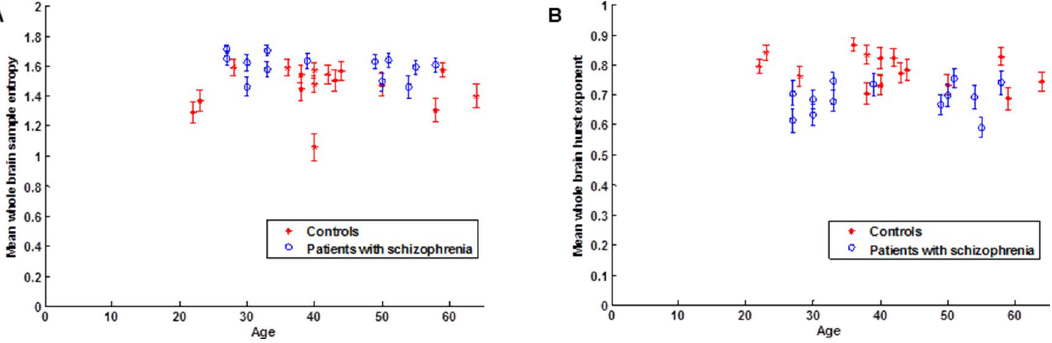
Figure 2. Plots of mean whole brain complexity of the individual participants with increasing age. (A) Mean whole brain Sample entropy. (B) Mean whole brain Hurst exponent. Error bars denote the standard error of the